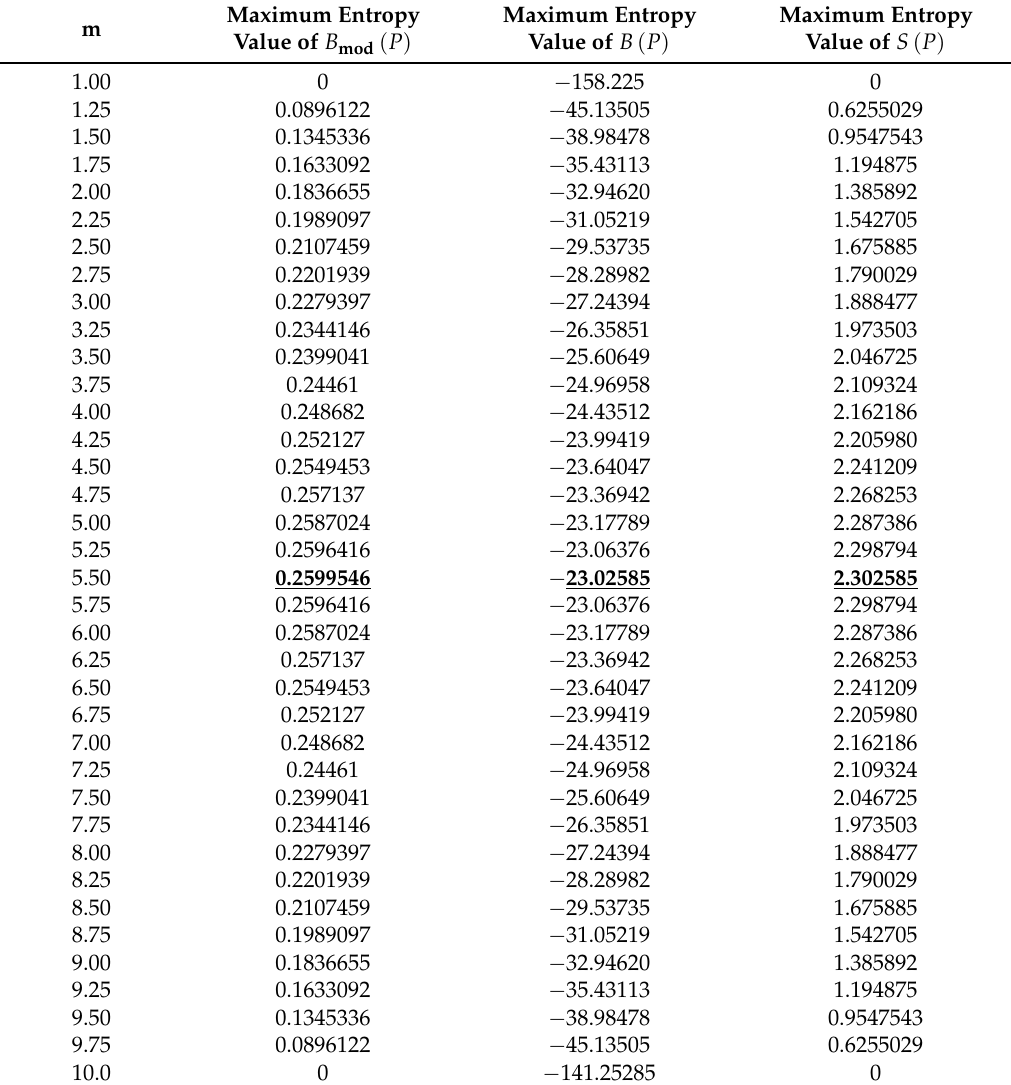
Table 2. Comparative Maximum Entropy